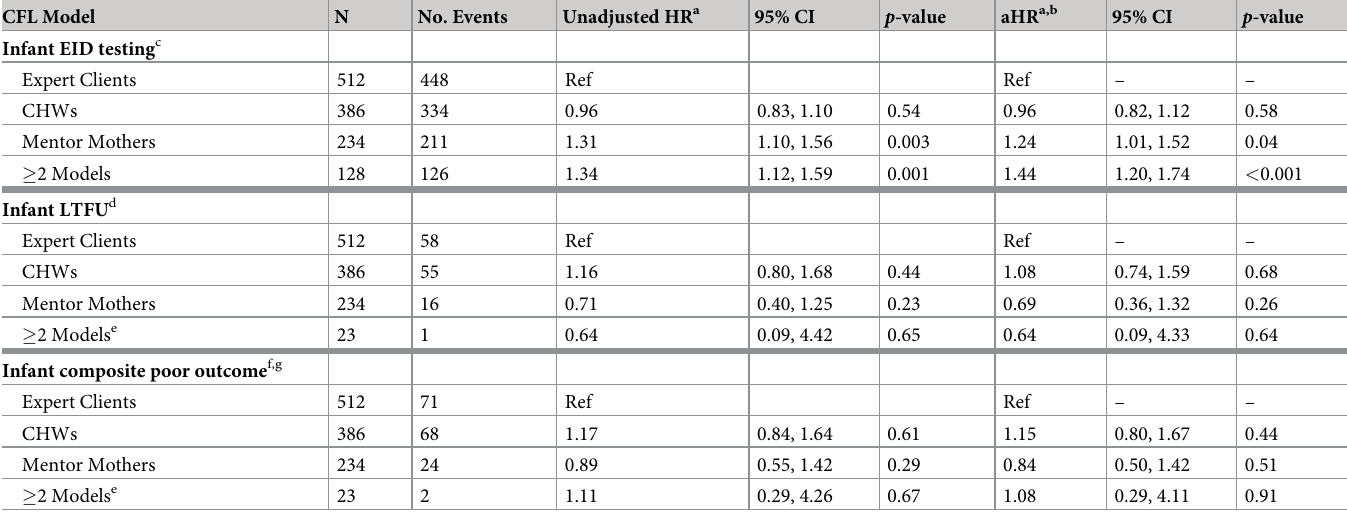
Table 3. Comparison of infant health outcomes by CFL model over the first year of life ( N = 1,260). CFL Model N No. Events Unadjusted HR